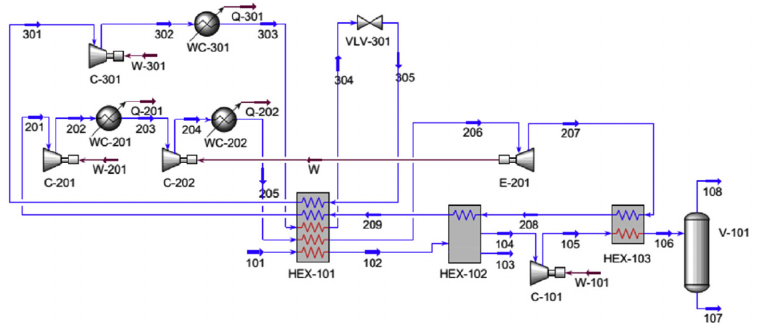
Figure 57. The proposed process with precooling [208]. Reproduced with permission from